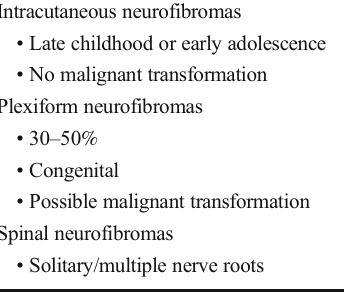
Table 3 Different subtypes of